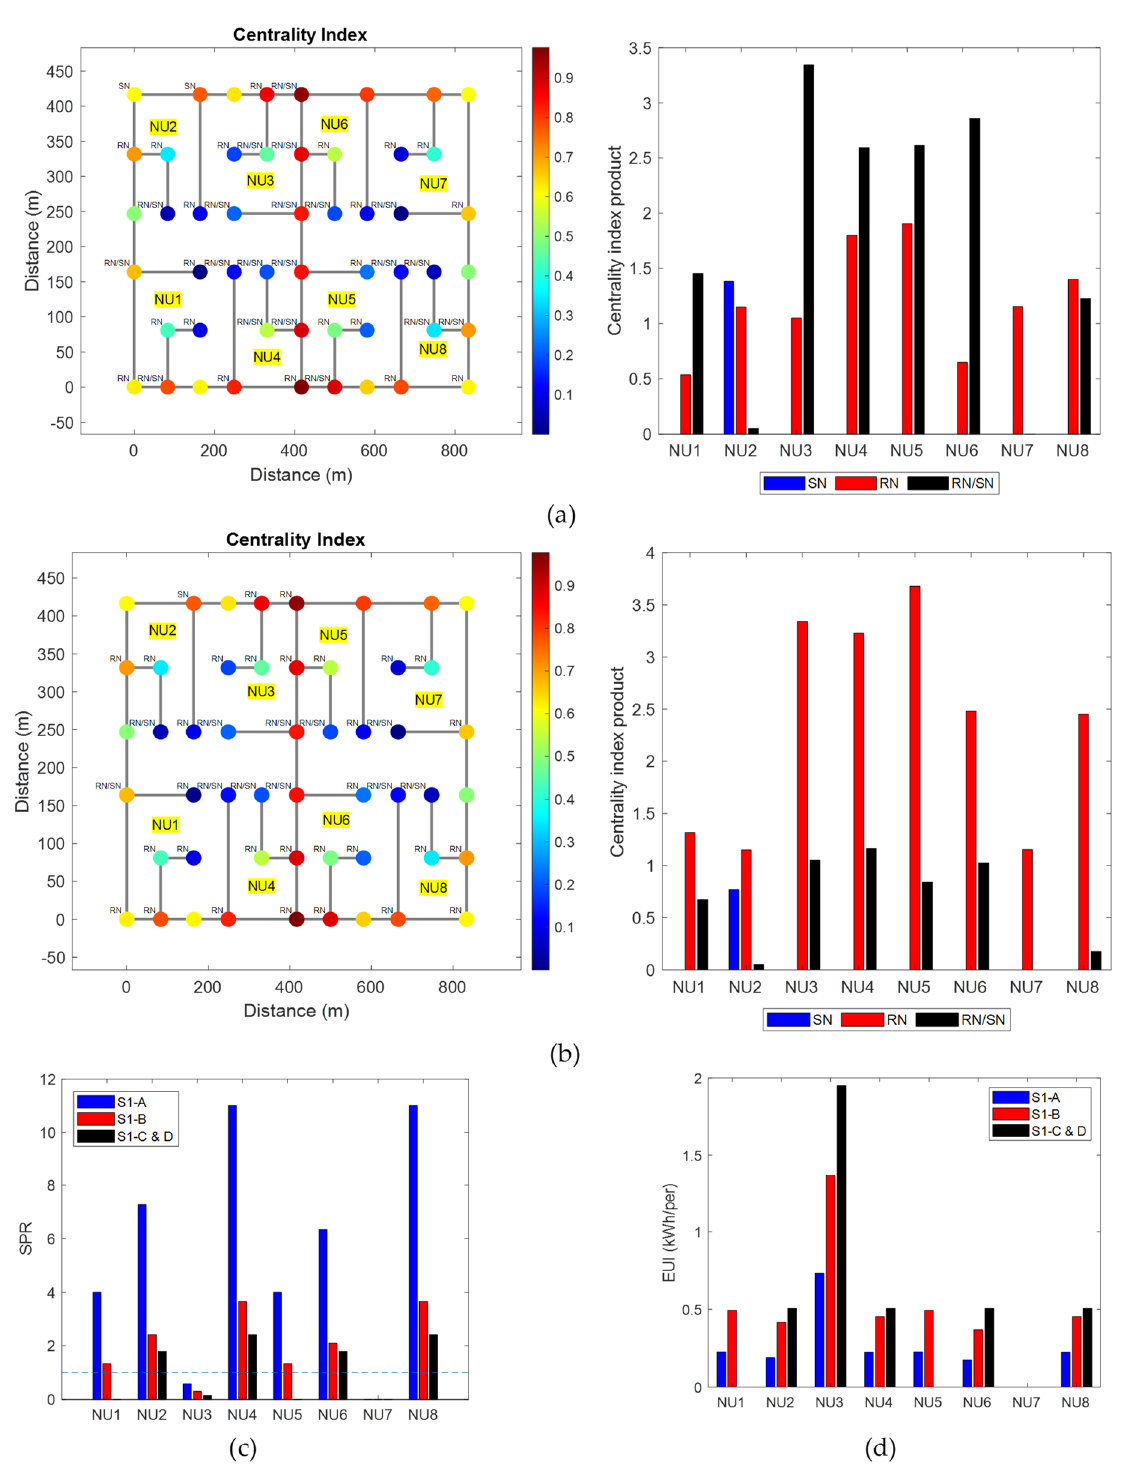
Figure 2. Centrality analysis of combination C1 ( a ) for scenarios S1 − A and S1 − B, ( b ) for scenarios S1 − C and S1 − D along with ( c ) shelter to population ratio (SPR) and ( d ) energy use index (EUI).